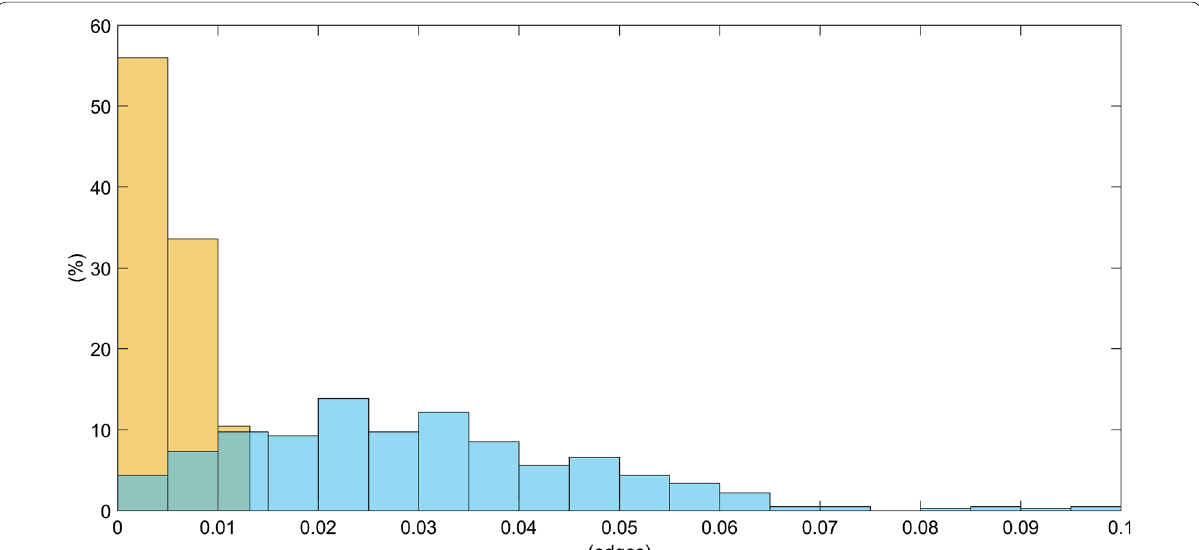
Fig. 8 Histogram of hydrostatic (yellow) and wet (blue) absolute slant factor (unitless) bias at 3° elevation angle for the GPS DDA stations. The larger spread of the wet mapping factor is noticeable along a small positive shift of the mean value